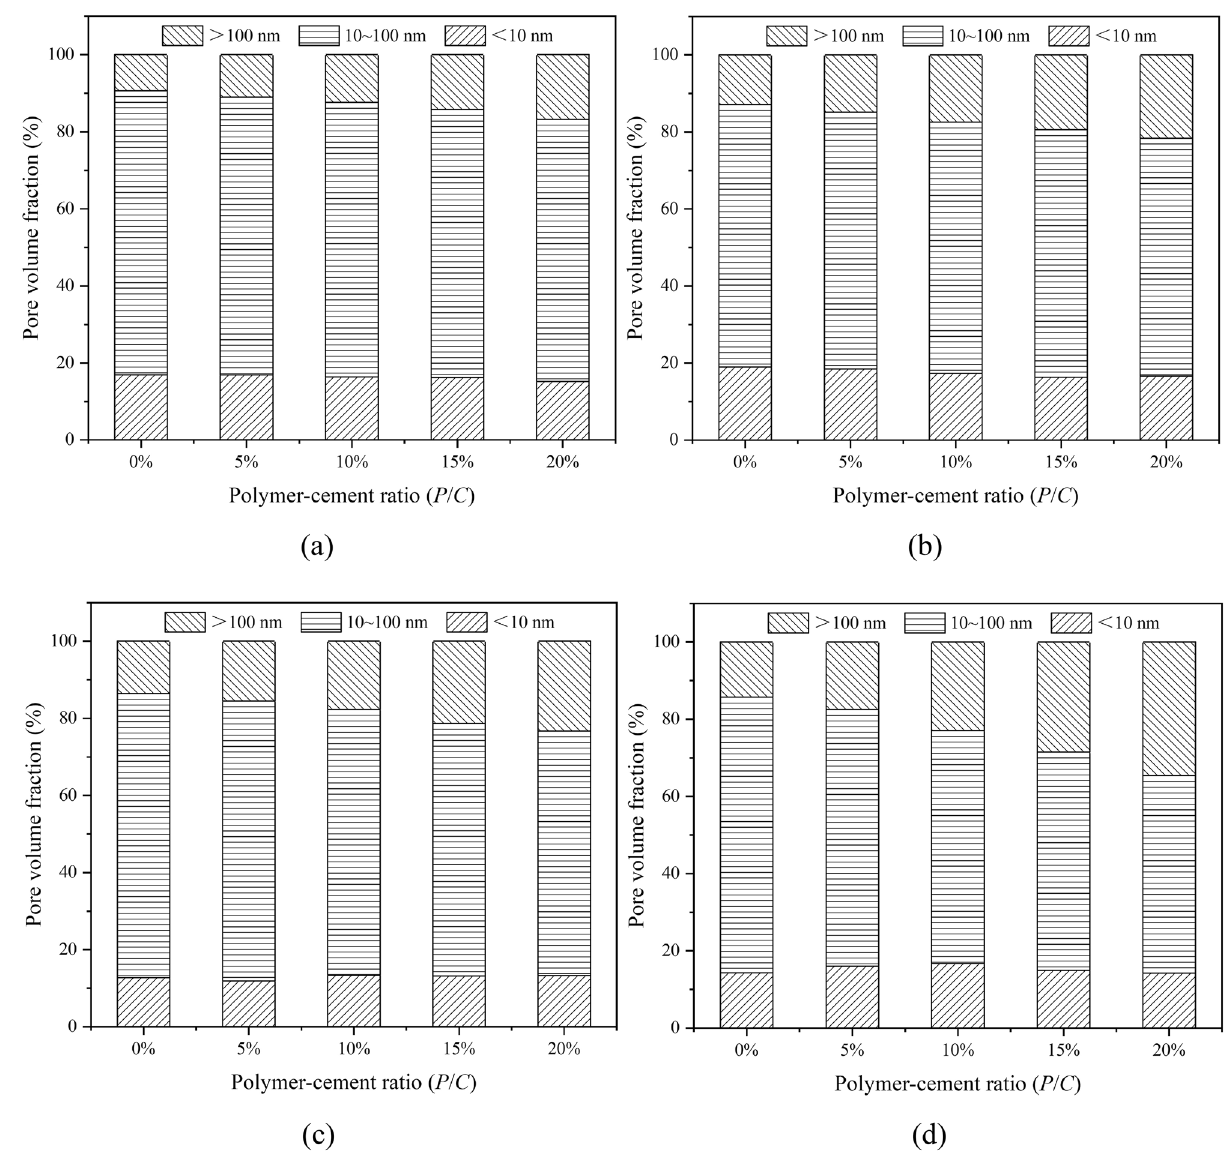
Figure 5. Pore volume distribution of epoxy latex-modified mortar with pore classifications at ( a ) 7, ( b ) 14, ( c ) 28, and ( d ) 90